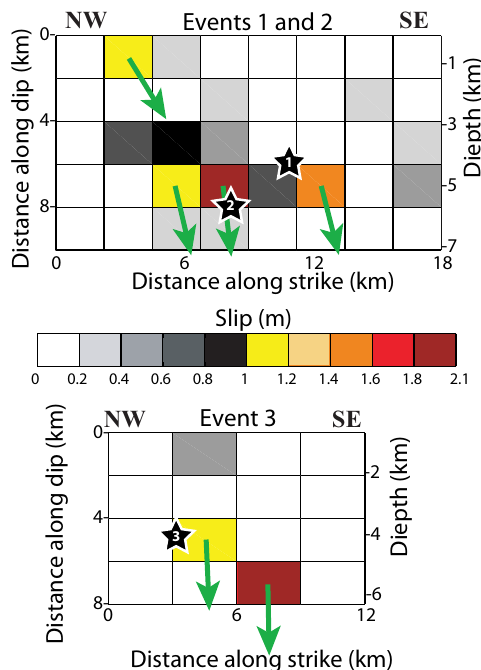
Fig. 3. Joint inversion of GPS data and DInSAR data performed by Lundgren and Stramondo (2002) for the slip distribution of events 1 and 2 (top) and event 3 (bottom). The inverted direction of slip (nor- malized vectors) is shown in the patches of slip larg- er than 1 m (green arrows). Black stars represent ver- tical projections of the observed epicentres on the in- verted fault planes. Events 1 and 2 are assumed on the same fault plane (see section 3.2.1.). Faults are assumed as rectangular dislocations in an elastic ho- mogeneous